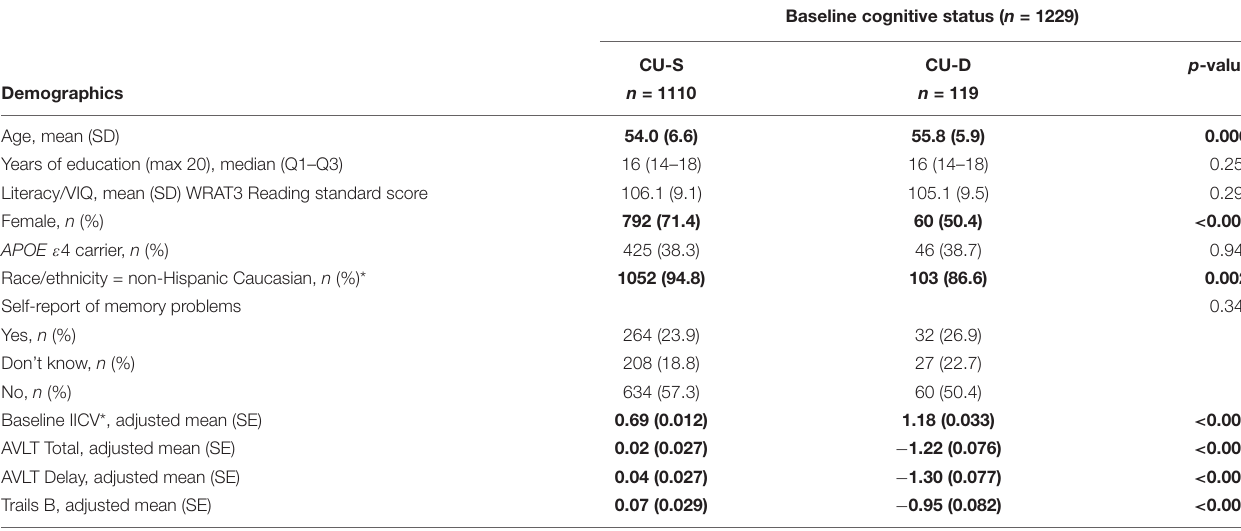
TABLE 5 | Sample characteristics in larger sample used to examine the progression